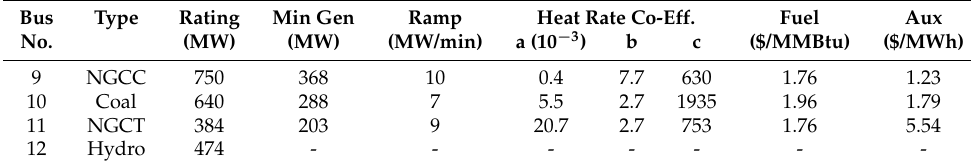
Figure 4. The operation cost in $/MWh including the fuel and auxiliary costs for the thermal units considered. The cost rate in $/h can be calculated as a product of the operation cost and the generation. Table 1. Specifications for the generating units in the modified IEEE 12 bus test case